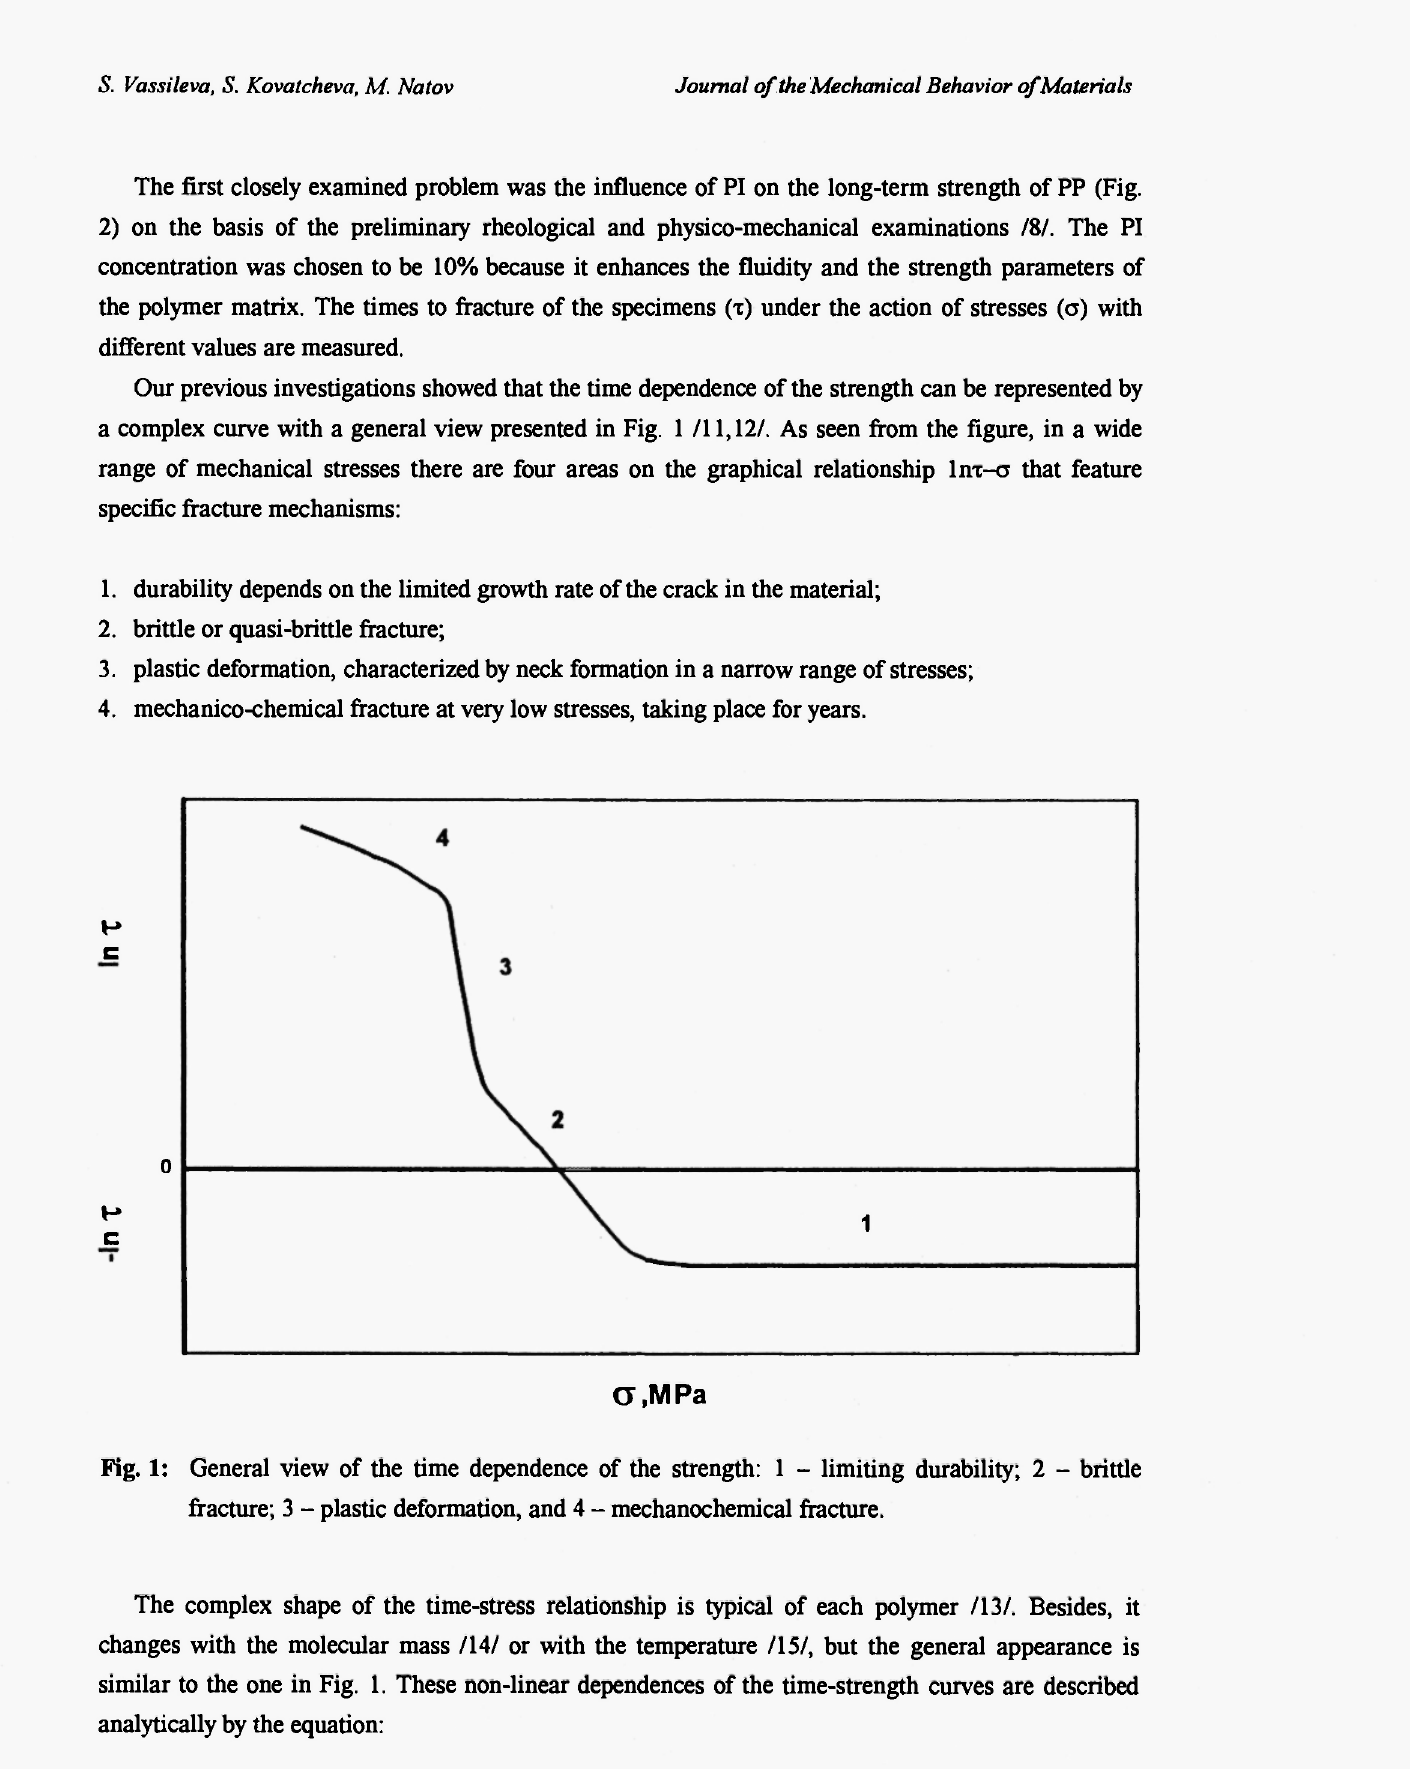
Fig. 1: General view of the time dependence of the strength: 1 - limiting durability; 2 - brittle fracture; 3 - plastic deformation, and 4 - mechanochemical